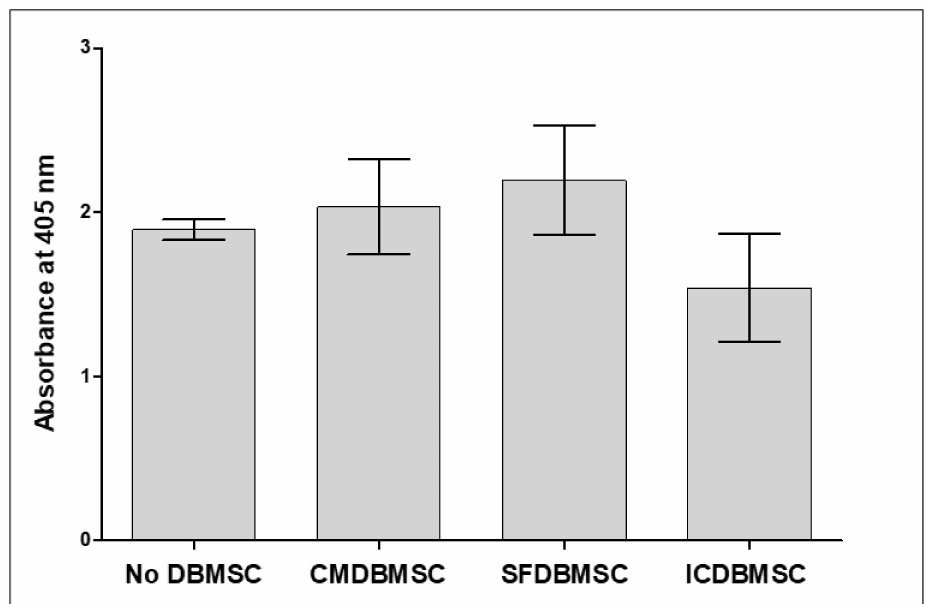
Figure 8. Functional assay of the phagocytic activity of monocytes differentiated into macrophages by GM-CSF in the presence of human DBMSCs. Phagocytosed Zymosan particles were measured by reading the optical density at 405 nm. Phagocytosis of Zymosan particles by macrophages was not significantly affected by DBMSC treatments compared to macrophages cultured alone. both monocyte-derived macrophages and DBMSCs. Bars represent standard errors.